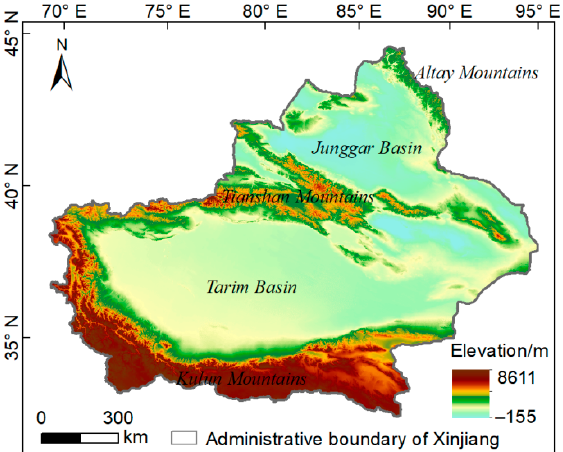
Figure 1. Schematic diagram of the study area.